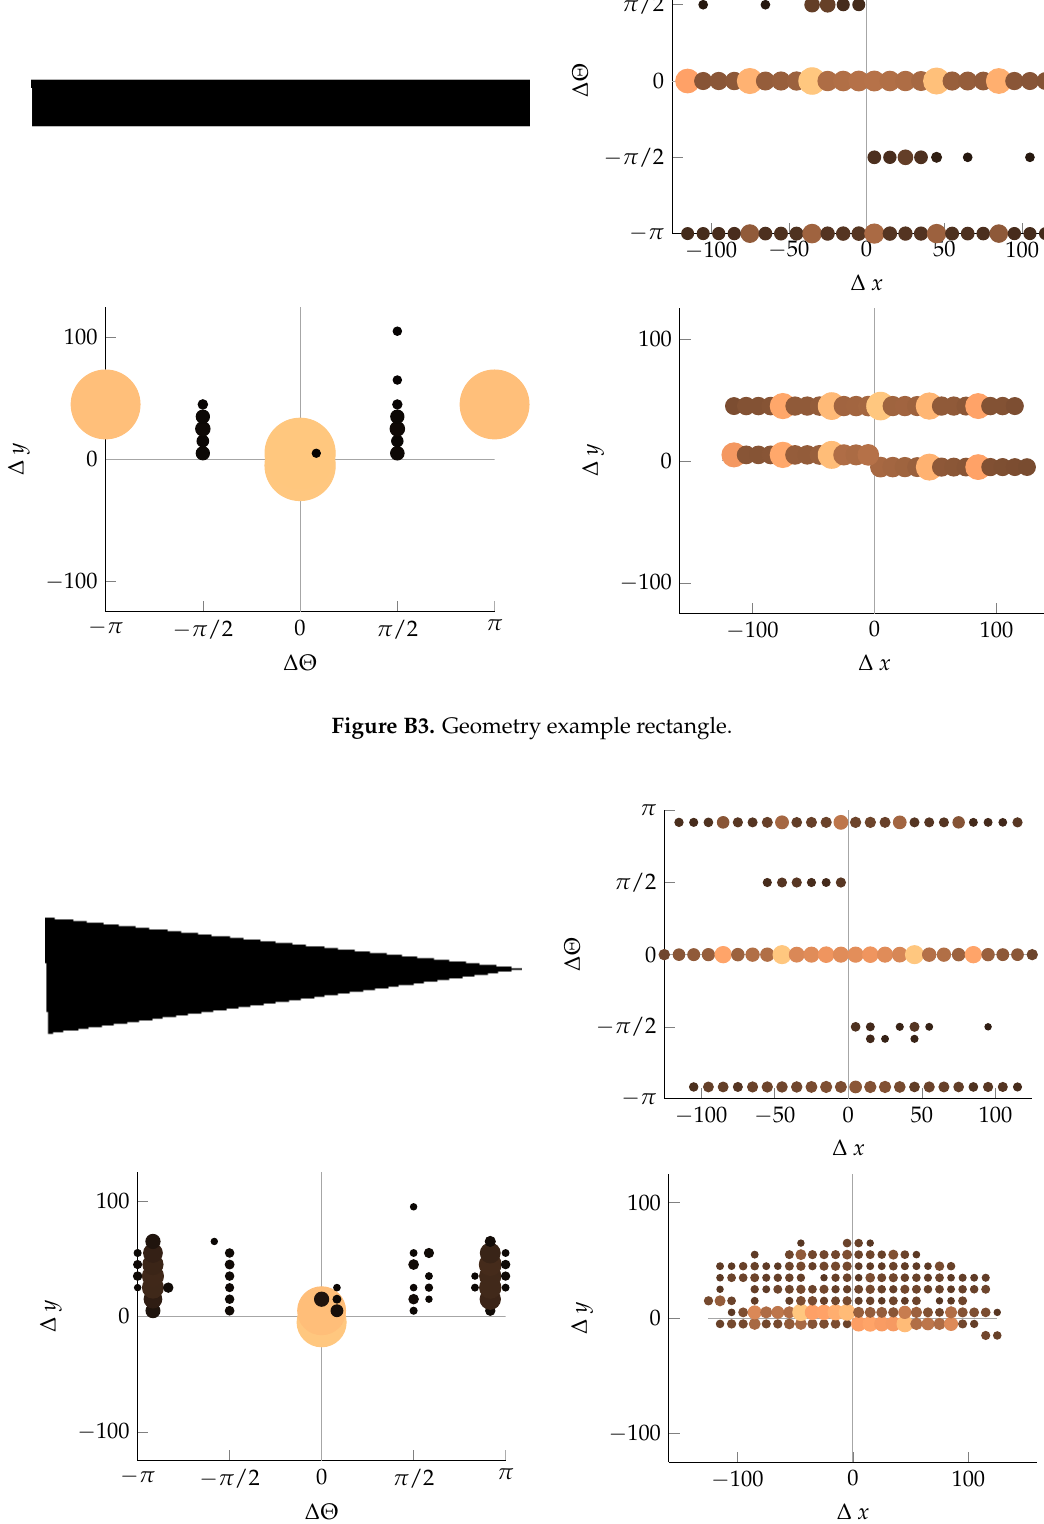
Figure B4. Geometry example